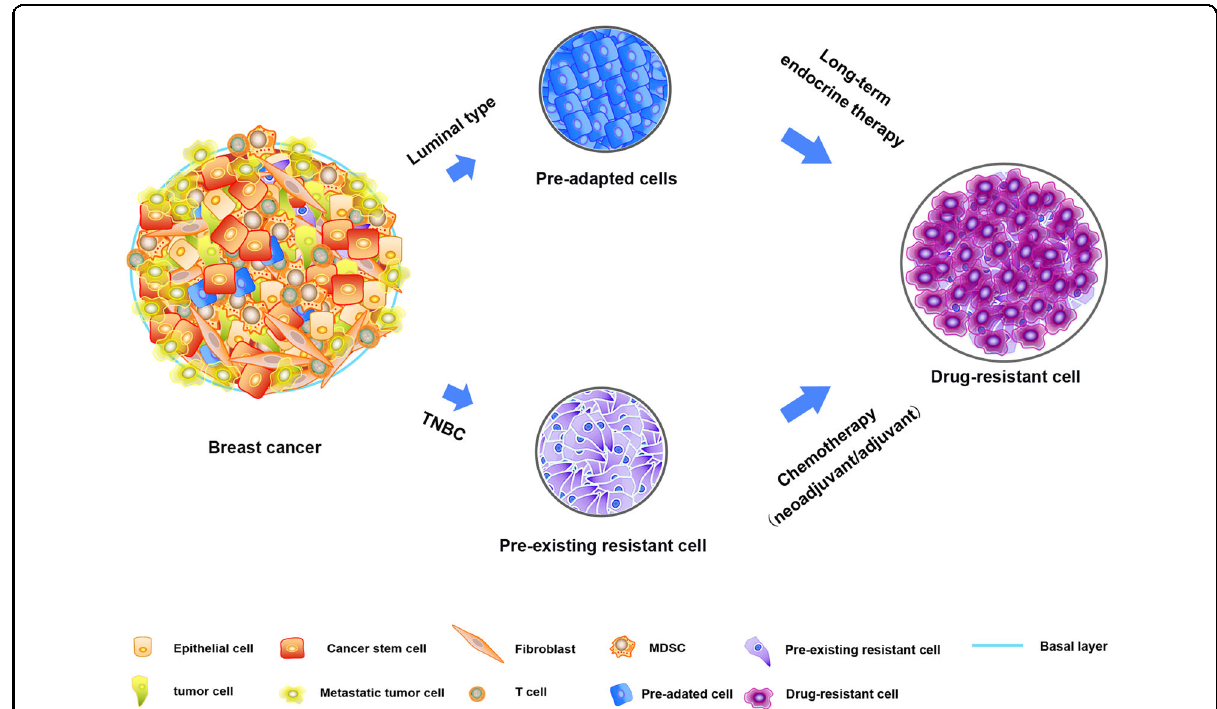
Fig. 2 The potential mechanisms of breast cancer cells acquiring drug resistance revealed by the scRNA-seq. The pre-adapted and pre- existing resistant cells exist in the luminal breast cancer and TNBC respectively, and they are expanded contribute to drug resistance after endocrine therapy or